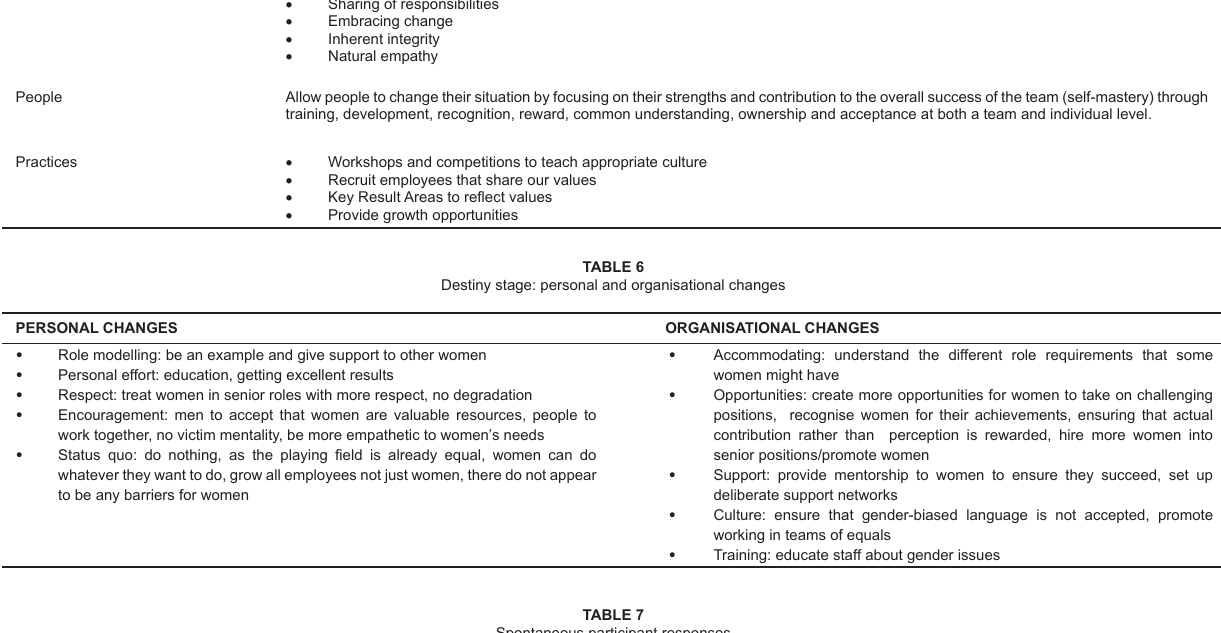
TABLE 7 Spontaneous participant responses